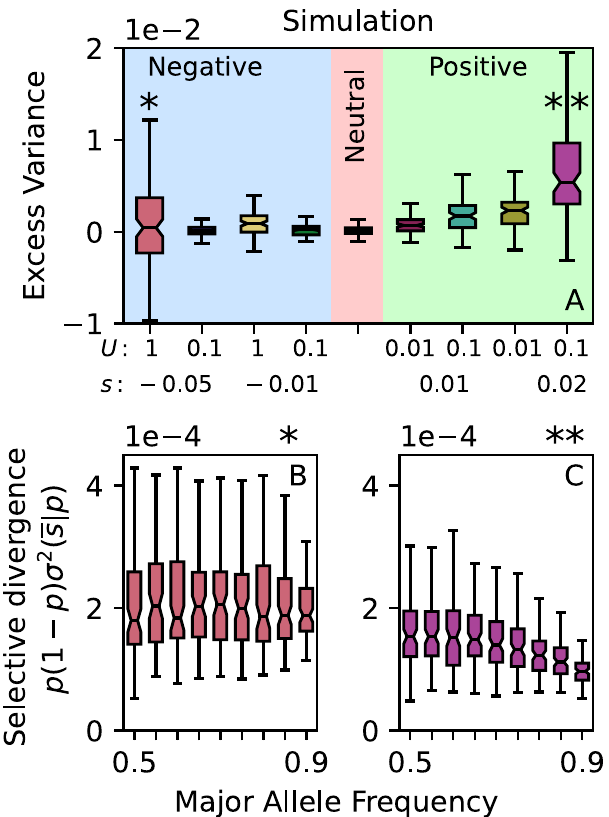
0.95 and t = 10 generations. (B) Under strong negative selection (deleterious mutation rate U = 1/genome/generation, mutation selection coefficient s = − 0.05), total selection coefficients are substantial at all frequencies but much stronger for high major allele frequencies resulting in a frequency-independent overall selective divergence p ð 1 (cid:0) p Þ s 2 ð s j p Þ like the neutral case. (C) In contrast, the selective divergence p ð 1 (cid:0) p Þ s 2 ð s j p Þ shows clear frequency dependence under positive selection, thus producing excess variance at intermediate frequencies. Population size N = 1000; 100 replicates per parameter combination. Stars indicate which panel A simulations are shown in panels B and C